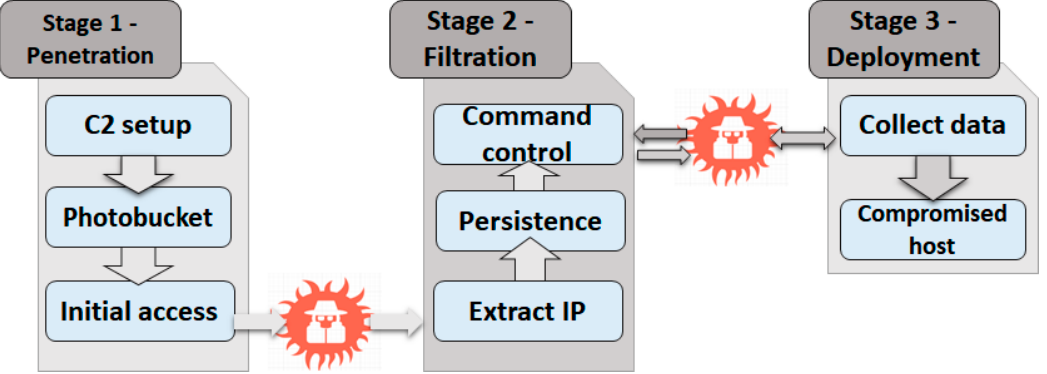
Figure 3. Malware penetration stages .